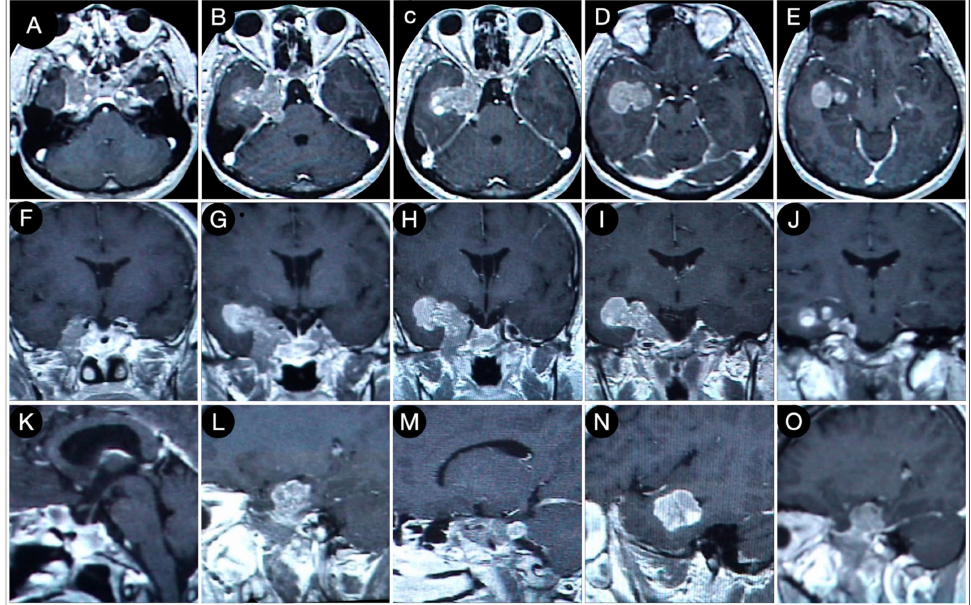
Figure 7. Axial ( A – E ), coronal ( F – J ), and sagittal ( K – O ) T1-weighted contrast-enhanced MRI per- formed six months after the trans-sphenoidal resection of the sellar part of the tumor. Scale bar: 5